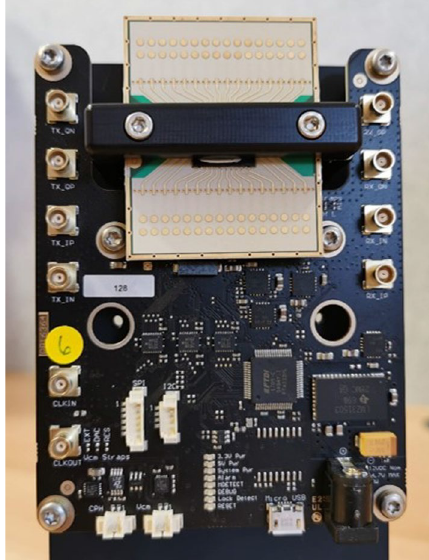
Fig. 15 60 GHz WiGig evaluation kit for 802.11ad beam-steering transceiver RFIC integrated with 2 × 16 antenna array. A metallic heatsink is placed on top of the chip for efficient heat